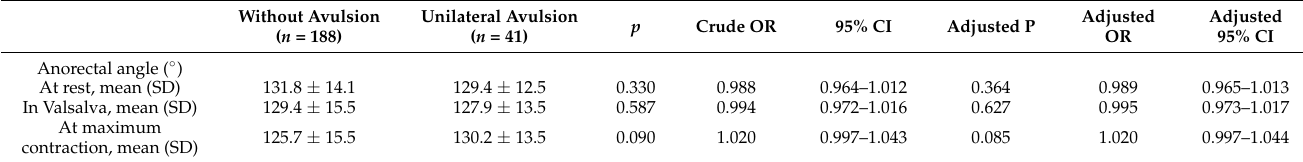
P a = comparison between the without avulsion group and unilateral avulsion group. P b = comparison between the without avulsion group and unilateral avulsion group. P c = comparison between the unilateral avulsion group and bilateral avulsion group. Table 2 compares the ARA between patients without LAM avulsion and patients with unilateral LAM avulsion. We observed no statistically significant differences in the measurements of the ARA at rest, in Valsalva and during maximum contraction between the groups. Table 2. The ARA in patients without LAM avulsion and in patients with unilateral LAM avulsion. ORs were adjusted for maternal age in